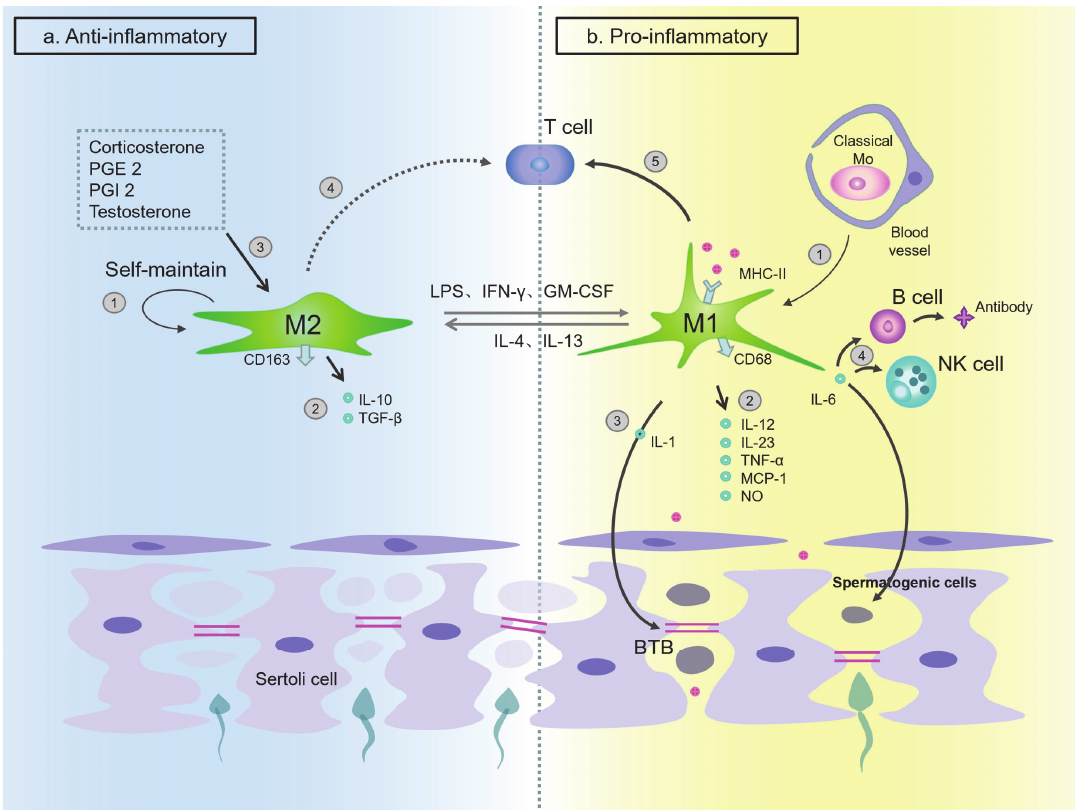
Figure 3. Regulation of testicular macrophages in physiological conditions (mainly anti ‐ inflamma ‐ tory) and pathological conditions (mainly pro ‐ inflammatory). ( a ) Under physiological conditions, the testes are dominated by M2 macrophages, which exert anti ‐ inflammatory and immune tolerance functions. ① Under normal conditions, M2 can independently maintain itself. ② M2 macrophages mainly secrete anti ‐ inflammatory cytokines such as IL ‐ 10 and TGF ‐β . ③ The M2 anti ‐ inflammatory phenotype is maintained by corticosterone, PGE 2, PGI 2, and testosterone in the surrounding inter ‐ stitial fluid (IF). ④ Due to the lack of co ‐ stimulatory molecules, the antigen presentation process of M2 macrophages to T cells is blocked. ( b ) Under pathological conditions, M1 macrophages become the quantitatively dominant group and mainly play a pro ‐ inflammatory function. ① Classical mon ‐ ocytes are recruited to the testes and differentiate into M1 macrophages. ② M1 macrophages mainly secrete pro ‐ inflammatory cytokines such as IL ‐ 1, IL ‐ 6, IL ‐ 12, IL ‐ 23, TNF ‐α , MCP ‐ 1, and NO. ③ Among them, IL ‐ 1 is an important inflammatory factor, which can regulate the permeability of the blood–testicular barrier (BTB). ④ IL ‐ 6 can promote B cell differentiation, T cell antibody secretion, and directly or indirectly enhance the killing activity of natural killer cells (NK cells); in vitro exper ‐ iments have found that IL ‐ 6 can also induce spermatogenic cell apoptosis. ⑤ M1 macrophages are MHC II positive, thereby participating in the presentation of antigens to activate T cells. In the testes,